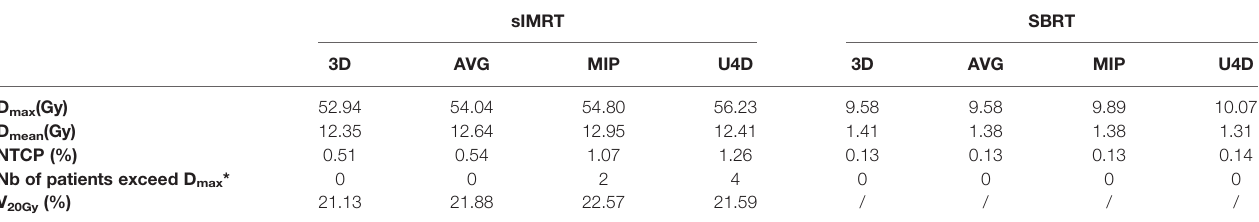
TABLE 5 | List of dose parameters that are statistically different from U4D ESO .